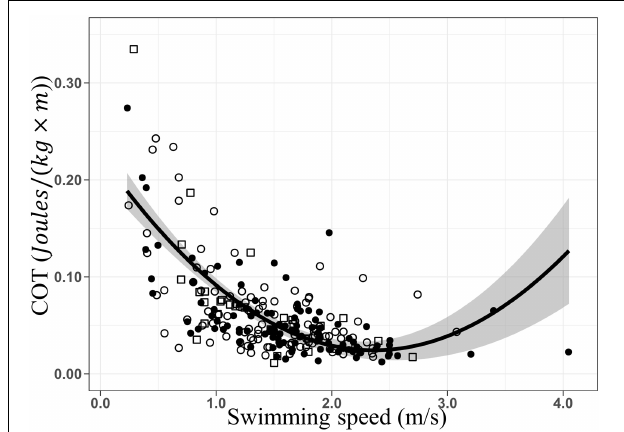
FIGURE 6 | Quadratic regressions of the mass-specific cost of transport (COT; J × [kg × m] - 1 ) as a function of the swimming speed (m/s). COT = 0.22–0.17 × S+0.03 × S 2 , R 2 = 0.46, F-stat = 103.8, p = 2.2e - 16 . Data from before ( (cid:13) ), during ( • ), and after ( (cid:3) ) the presence of the whale-watching boats. Gray area represents the standard